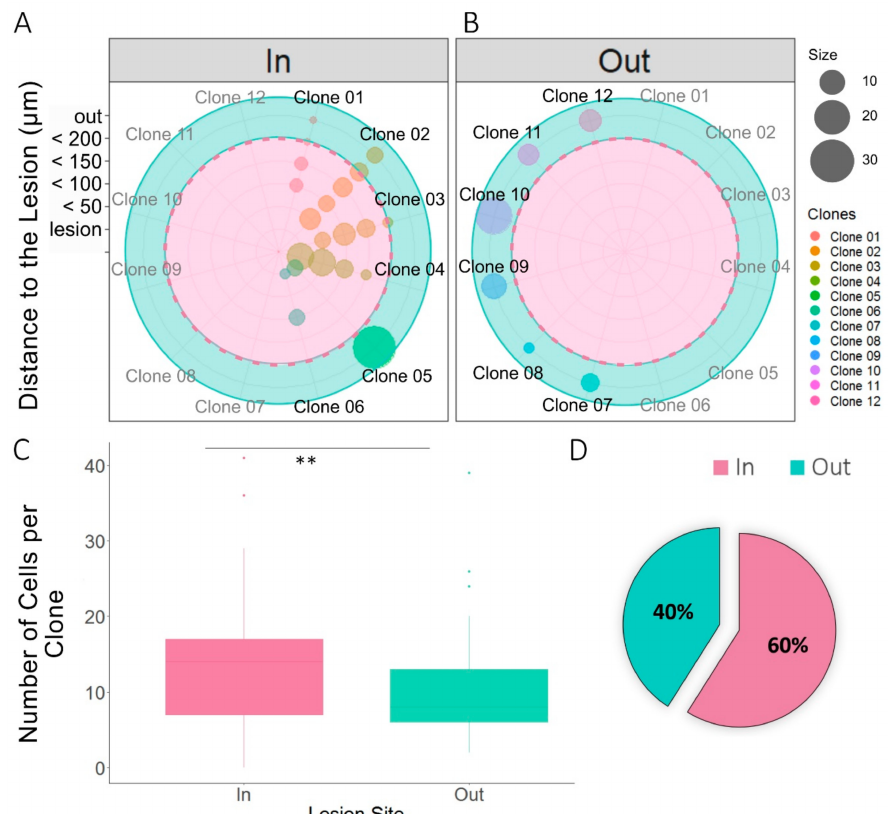
Figure 3. Dispersion of NG2-glia clones relative to the lesion. ( A , B ) Radial plots of sibling NG2-glia dispersionaccordingtotheirdistancefromtheEAElesionandthenumberofclonally-relatedcells. Theradii represent the lesion core area and the different consecutive perimeters (up to 200 µ m) surrounding that area at an interval of 50 µ m. All cells further than 200 µ m away from the lesion core were considered to be outside of the lesion area (green area), and cells within 200 µ m were considered to be inside the lesion area (pink area). Quadrants separate sibling cells of inner clones (01–06) ( A ) and from the outer clones (07–12) ( B ). Inner clones were described as clones with one or more clonally-related cells within at least 200 µ m from the core. Sibling cells of six outer clones and six inner clones were represented, the sibling cells sharing the same color-code. ( C ) There were more clonally-related cells that formed clones within the lesion site (inner clones) than those that formed outer clones. Two-tailed unpaired Student’s t test was used to evaluate the statistically-significant differences between the two groups: ** p < 0.001. ( D ) From the NG2-glia clones analyzed ( n = 48), 60% had at least one sibling cell within the 200 µ m perimeter around the lesion. More inner clones than outer clones were